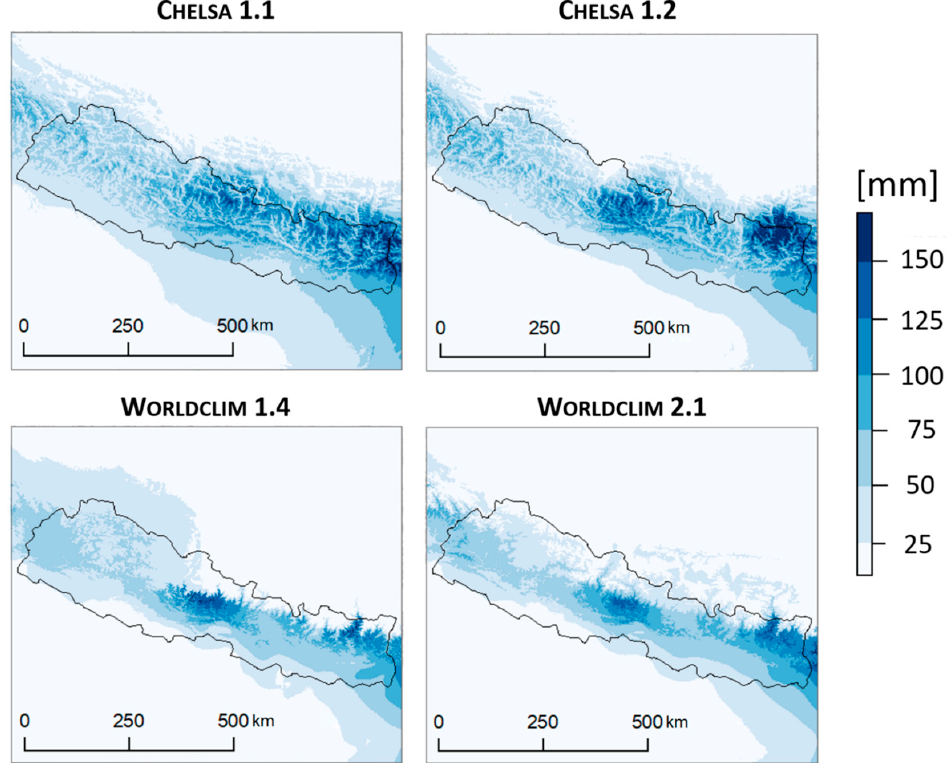
Figure 4. Average Precipitation in March, April, and May for all climate datasets and respective versions. The two W ORLDCLIM versions show severe artefacts on the Tibetan plateau, with these artefacts appearing ball-shaped in version 1.4 and more flattened and stretching to- wards the East in version 2.1 (Figure 3). Differences between the two versions can be par- ticularly attributed to the number of weather stations used for interpolations. Fick and Hijmans [32] stated higher prediction error with increase in station elevation and distance to nearest neighboring station, and further reported higher relative error in areas with complex topography (i.e., mountains) and low station density. Compared to W ORLDCLIM version 1.4, a higher number of weather station data points (version 1.4: 47,554, version 2.1: 60,419) were incorporated in version 2.1 to interpolate precipitation values. Further- more, they included cloud cover to increase accuracy in regions with low weather station density and sharply contrasting microclimates to emphasize topographic effects and avoid over-smoothing relationships between elevation and precipitation with stations at equivalent elevations across rain-shadows [61]. Correlation analyses revealed consistent high coefficients among versions and rather low coefficients between climate datasets, whereas the lowest coefficients were found for C HELSA 1.1 and W ORLDCLIM 1.4 as well as 2.1 (Table 4). In general, W ORLDCLIM shows lower precipitation values compared to C HELSA for Average Precipitation in March, April, and May (Figure 4). Comparing C HELSA 1.1 and 1.2, the circular arrangement of precipi- tation amounts remains, with highest values being predicted in the eastern parts of the study area and north of the Himalayan main range. This is suspicious, since the main range constitutes a barrier, leading to very dry climate on the Tibetan plateau. This artefact in C HELSA 1.2 is attributed to the interpolation of station-derived biases. The effect of re- mote sensing products to decrease bias of precipitation variables can be observed for Av- erage Precipitation in March, April, and May, with artefacts in the eastern part of the study area on the Tibetan Plateau being diminished in W ORLDCLIM 2.1 compared to 1.4.